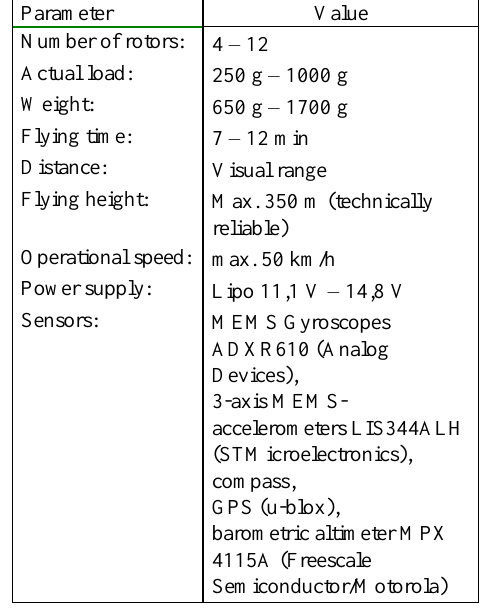
Table 1. Technical parameters of the MikroKopter system